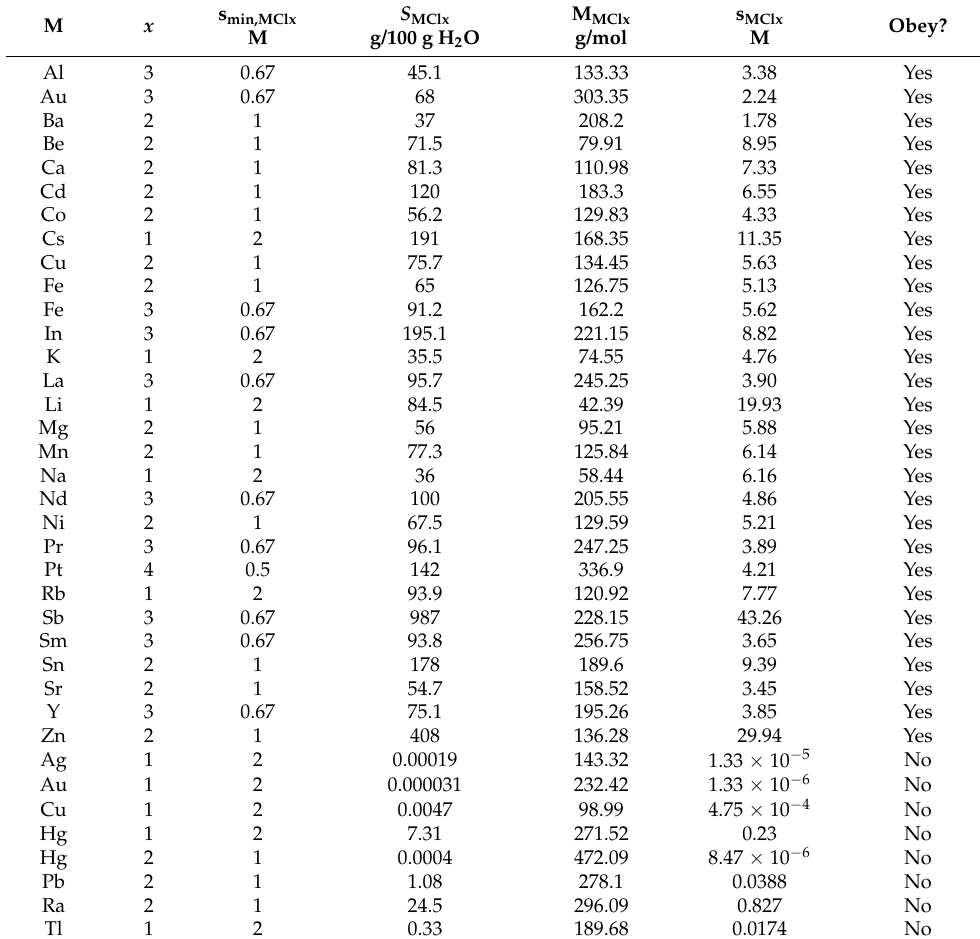
Table 2. Metal ions whose chlorides have (or not) high enough solubility to obey condition